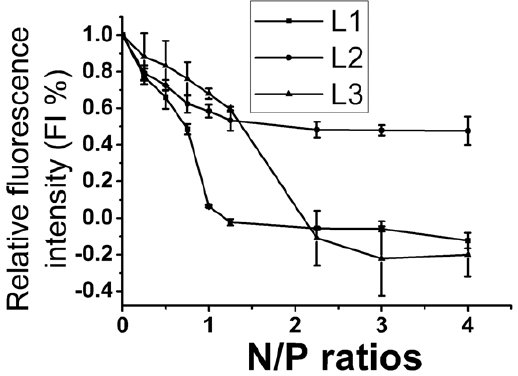
Figure 3. Release of the ethidium bromide (EB) from the CT (calf thymus) DNA-EB complexes upon addition of the liposomes (L1–L3) at different N/P ratios. All lipid/DOPE ratios were 1 : 2 and the concentration of CT-DNA was 11 m M.